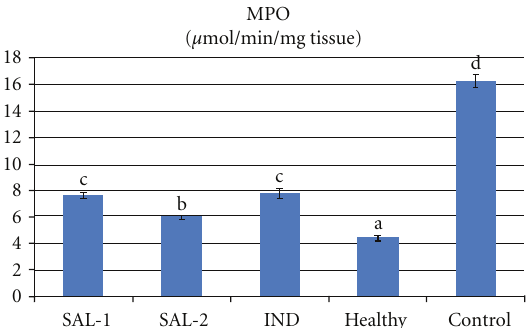
Figure 5: E ff ects of salbutamol (SAL) and indometacin (IND) on reduced glutathione (GSH) level in carrageenan-injected-paw tissues. Means in the same column by the same letter are not sig- nificantly di ff erent and the means in the same column by di ff erent letters demonstrate significant di ff erences between the groups according to the Duncan test ( α = 0 . 05). In the above figure, the letter for the means in SAL-2, IND, and healthy columns is the same: “c.” This demonstrates that values in these lines are not statistically di ff erent from each other. However, the lines with the letter “c” are statistically significant from the lines with the letters “a” and